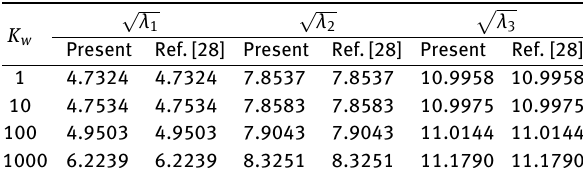
(︁ √ )︁ for CC case λ √ λ 2 √︀ λ 3